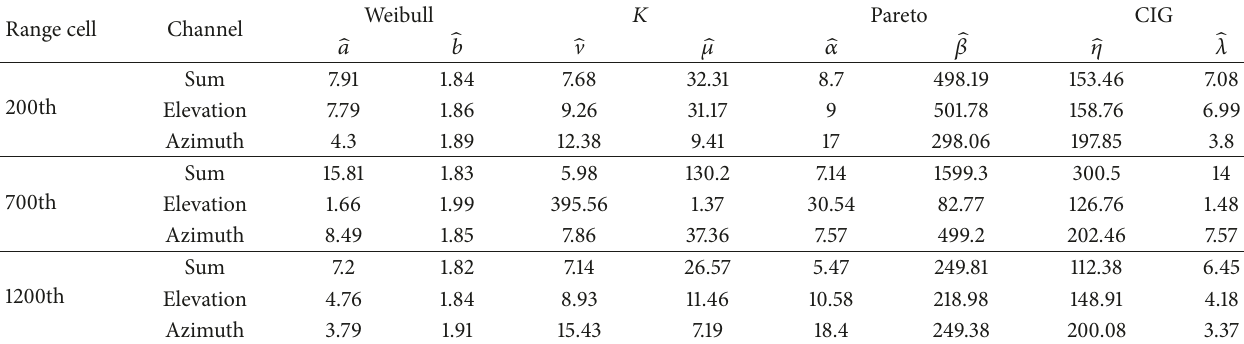
Table 3: Estimated parameters for different theoretical PDFs for DS1.